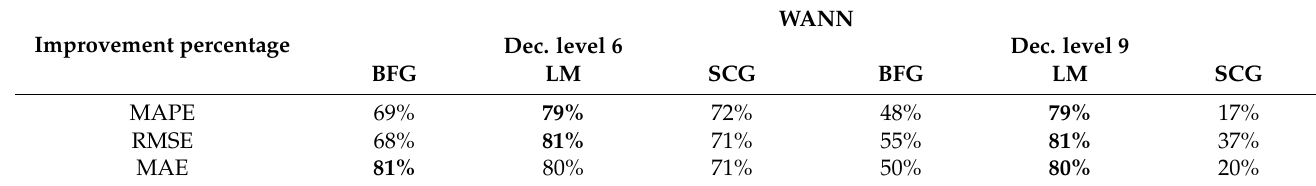
Table 6. WANN improvement percentage over conventional